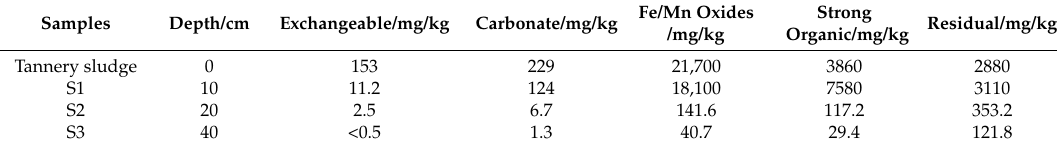
Figure 3. The distribution of major contaminants in the sludge-contaminated soil profile. Table 2. Contents of the different Cr species extracted by a Tessier procedure in the soil samples.